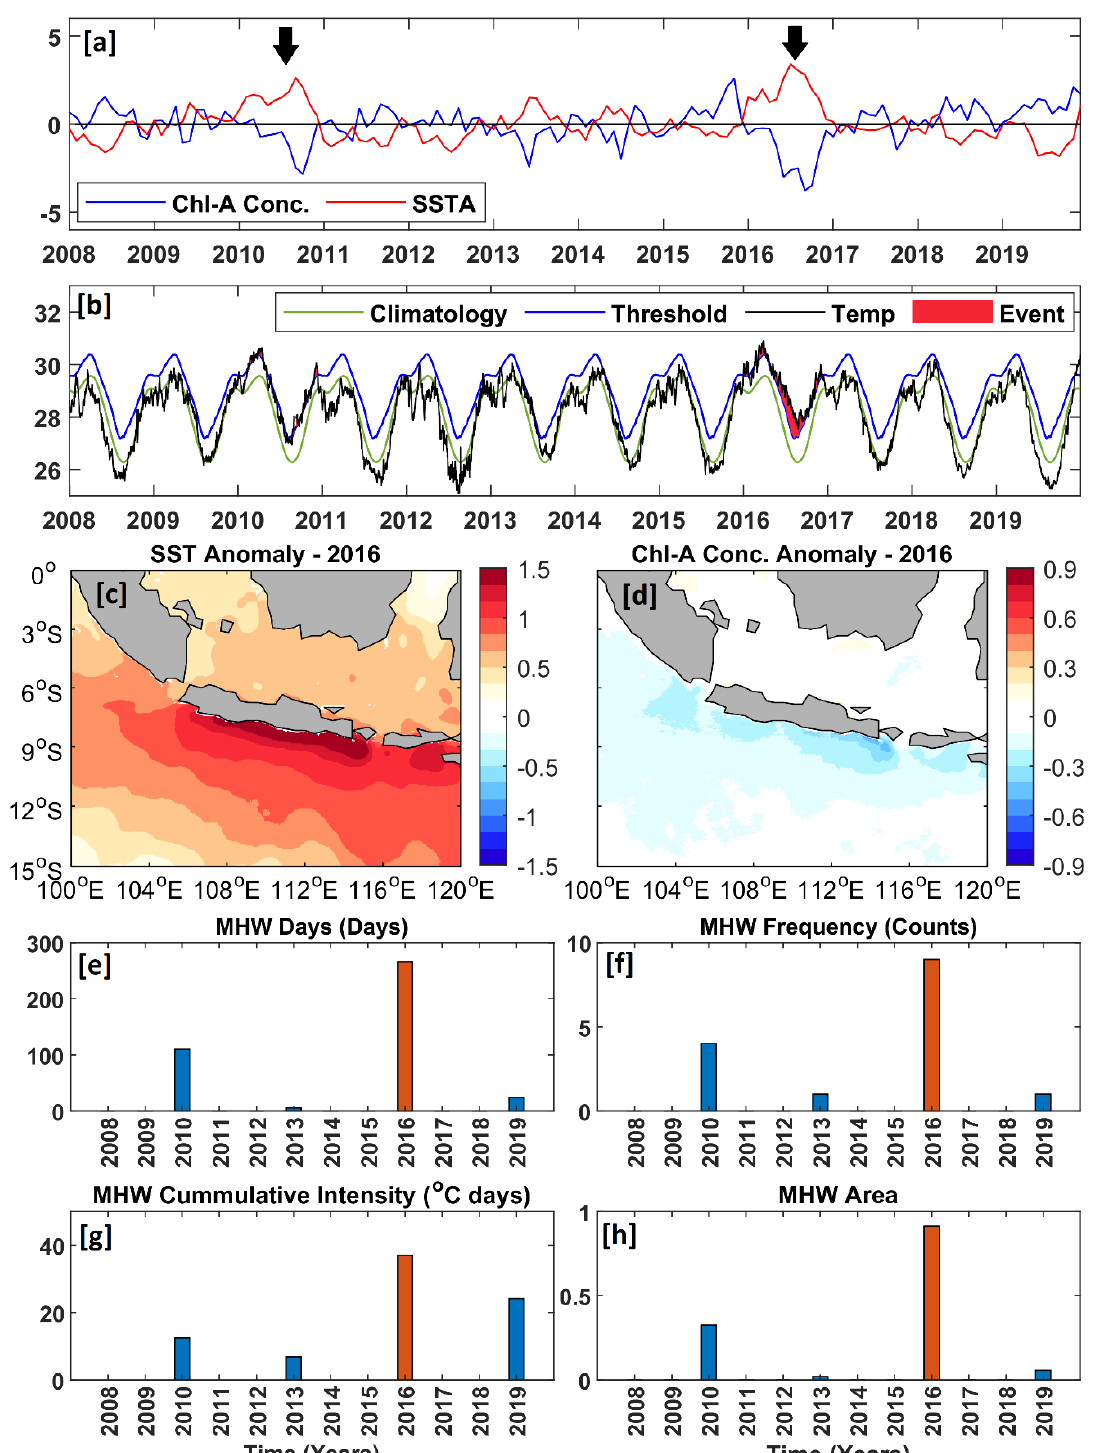
Figure 9. ( a ) Time series evolution of region-averaged, climatology removed and detrended chlorophyll-a concentration and SST anomaly during 2008–2019. ( b ) Time series of region-averaged SST (black line) during 2008–2019. The green and blue lines denote climatology and threshold SST. The red shaded portion indicates the marine heatwave (MHW) event. Spatial maps of ( c ) SST anomaly and ( d ) chlorophyll-a concentration anomaly averaged during 2016. The MHWs are characterized in terms of ( e ) MHW Days, ( f ) MHW frequency (counts), ( g ) MHW Cumulative Intensity ( ° C days) and ( h ) MHW area during 2008−2019 . The red bar is the strongest MHW event in 2016, indicated by the black arrow in panel ‘a’.